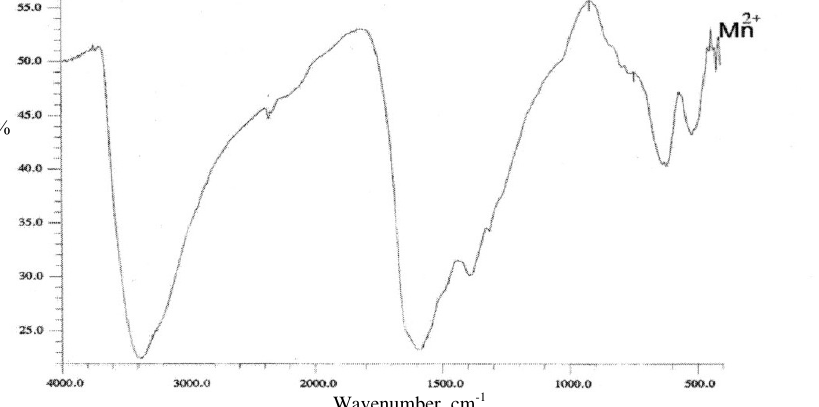
Figure 2. Infrared spectrum of Mn(II)-L 1 L 2 mixed ligand complex Electronic spectrum